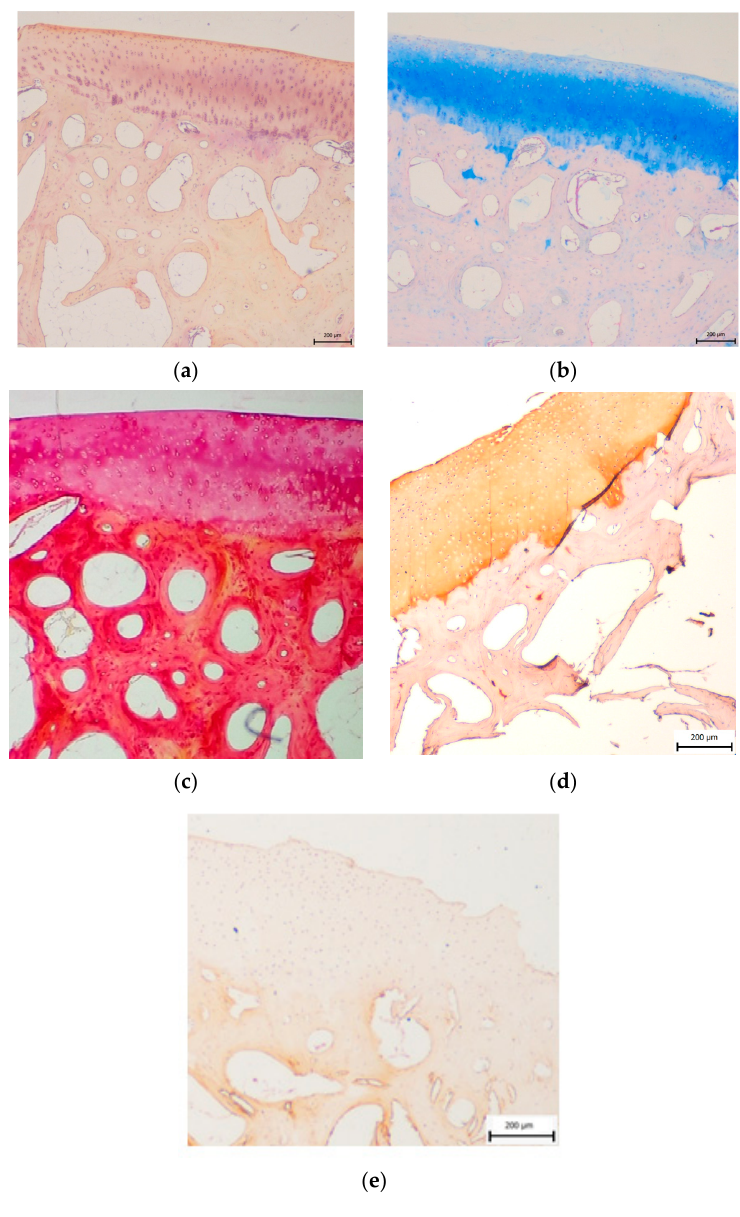
Figure 3. Control sample of hyaline cartilage and subchondral bone obtained from the native osteochondral stopper. ( a ) Haematoxylin ‐ eosin staining, ( b ) Alcian blue staining, ( c ) Picrisirius red staining, ( d ) immunohistochemical evidence of collagen II, ( e ) immunohistochemical detection of collagen I; scale bar = 200 μ m.